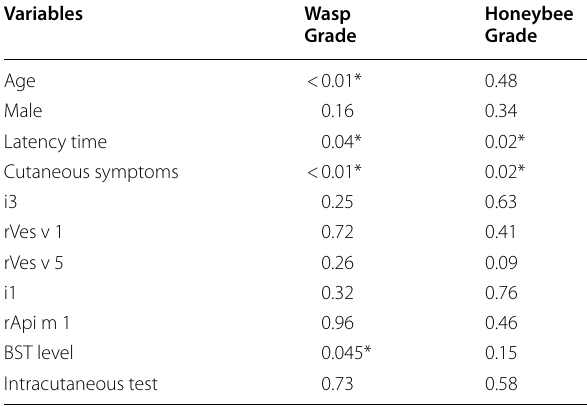
Table 2 Patient characteristics (percentage or standard Table 3 P-values of the ordinal logistic